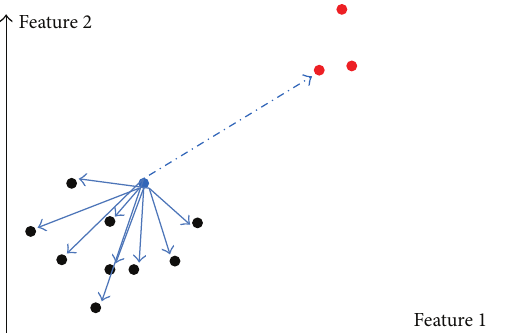
Figure 5: The effect of 𝐾 value on normal node’s 𝐾 -distance function (𝐾 = 𝑚1) .